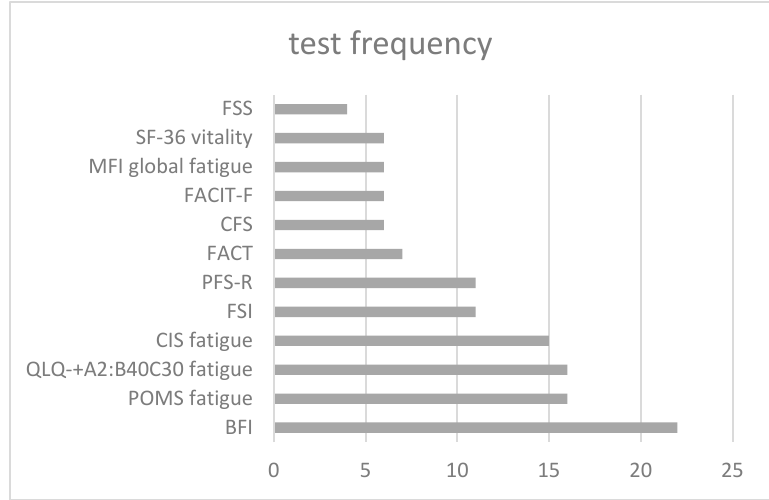
Figure 4. Test frequency.